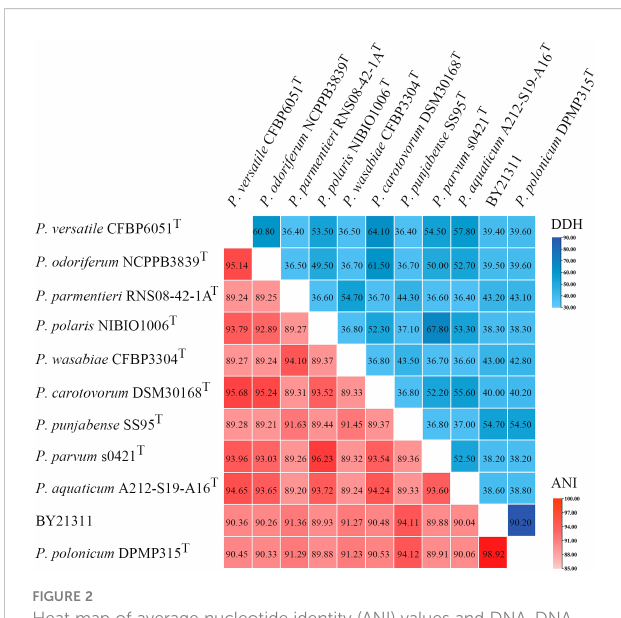
FIGURE 2 Heat map of average nucleotide identity (ANI) values and DNA-DNA hybridization (DDH) values compared among 11 related strains. ANI and DDH values are indicated by the color